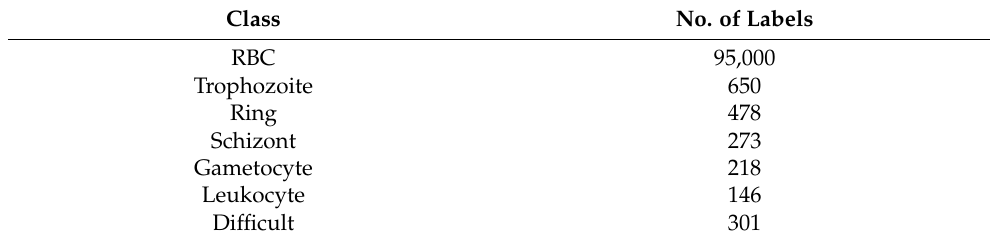
Table 2. Distribution of the number of labels between classes for stage classification dataset.